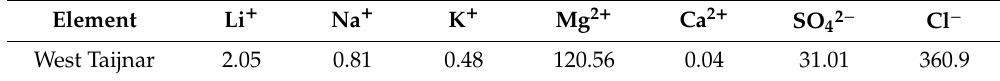
Table 1. The components of the West Taijnar Salt Lake brine (g · L − 1